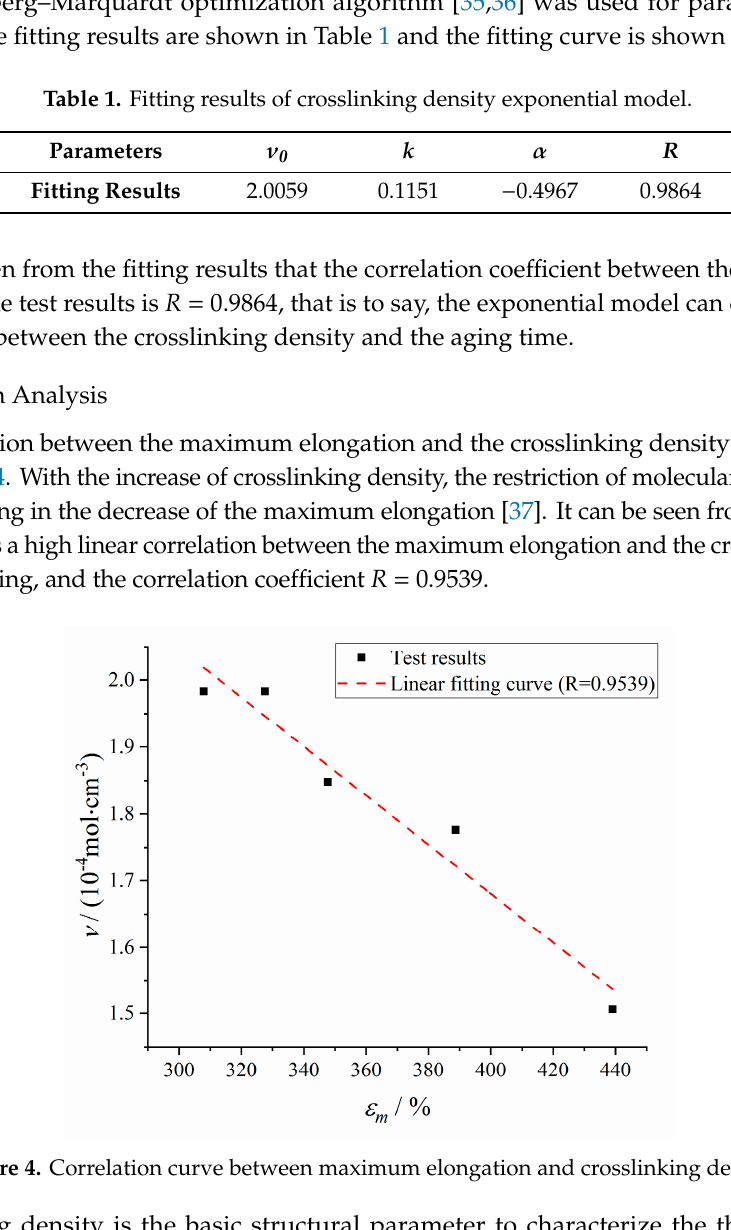
Figure 5. Changing curves of tan δ of the HTPB coating at different aging times.